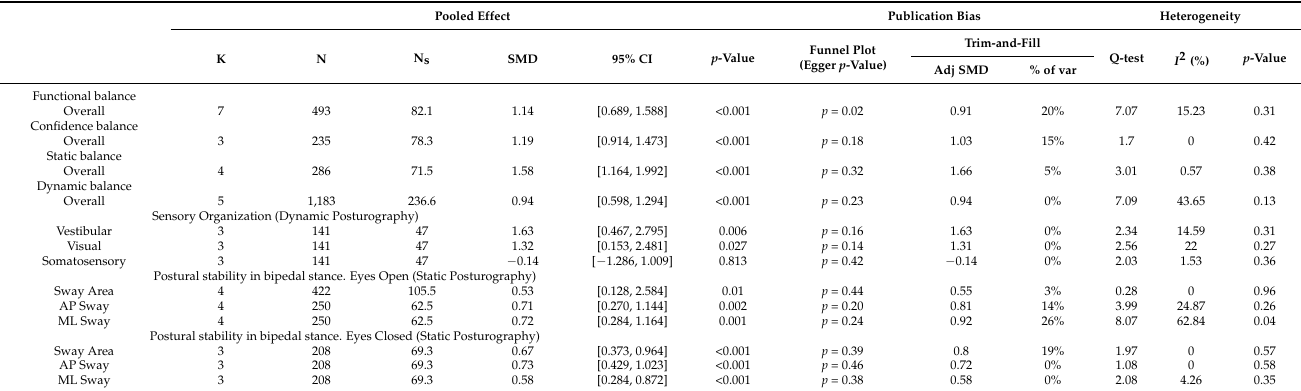
Table 4. Main findings in meta-analyses.